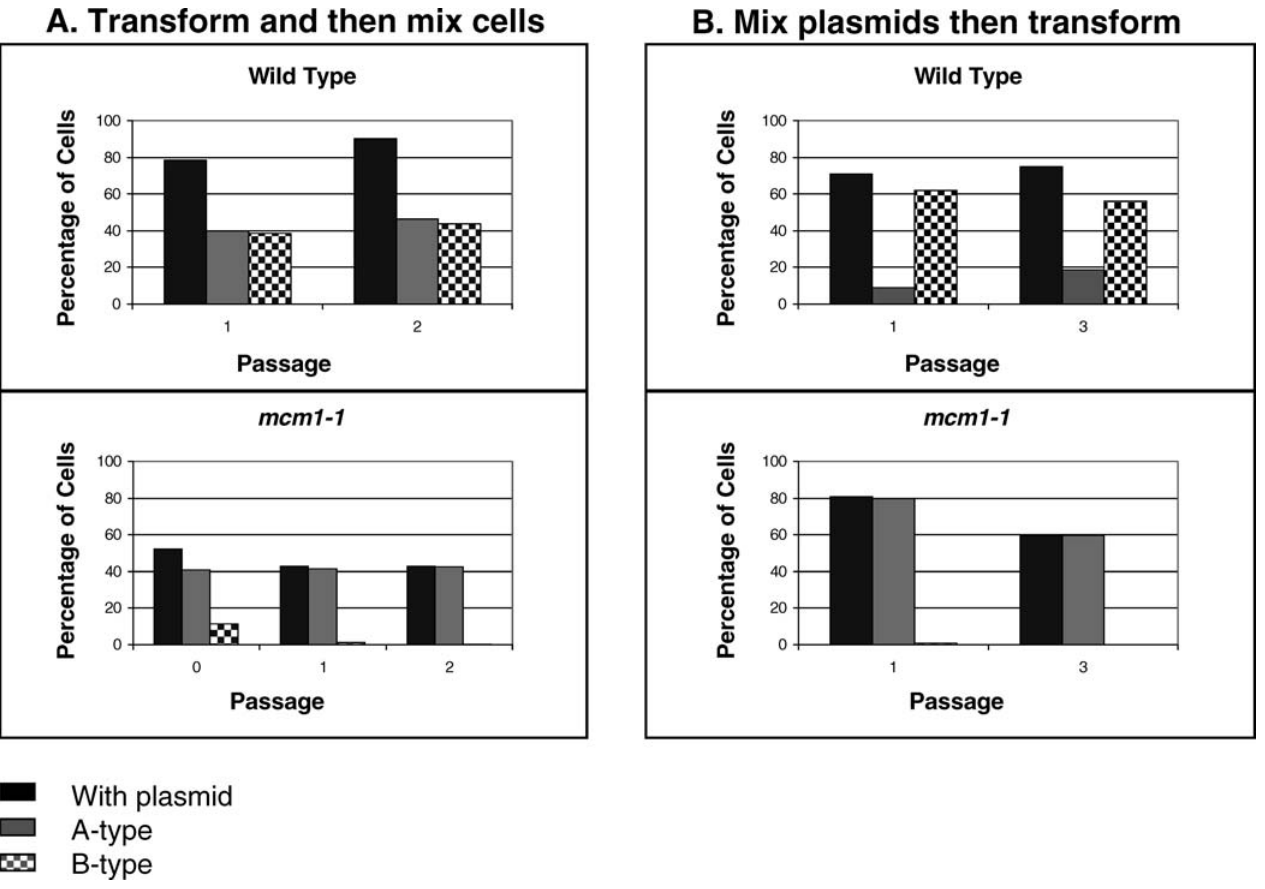
Figure 2. YCp121 Is More Stable than YCp1 in mcm1–1 Cells Cells (wild-type or mutant) containing YCp121 or YCp1 were mixed (A). YCp121 and YCp1 were mixed and transformed into wild-type or mcm1–1 cells (B). Colonies on selective medium were pooled and used to inoculate a culture in selective media. The culture was grown to saturation (one passage) and used to inoculate a fresh culture of selective media. This process was repeated two or three times. The relative abundance of YCp1 containing ARS1 and YCp121 containing ARS121 was measured at the end of a passage. DOI: